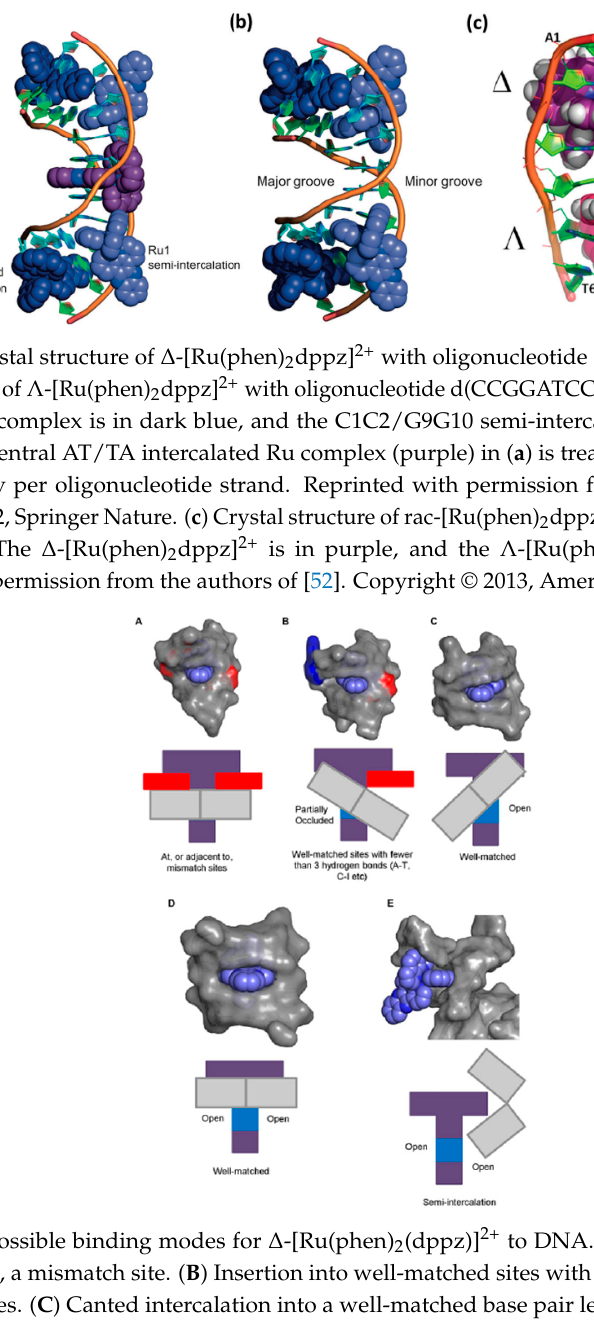
Molecules 2019 , 24 , x FOR PEER REVIEW 7 of 16 metallo-insertion, whereby the ruthenium complex (red) inserts the dppz ligand into the DNA duplex (grey) at the mismatched sites through the minor groove, extruding the mispaired adenosines (blue); (2) metallo-intercalation, whereby the complex (green) binds between two well-matched base pairs; (3) end-capping, whereby the complex (yellow) stacked with the terminal Watson-Crick pair of the duplex. Reprinted with permission from the authors of [26]. Copyright © 2012, Springer Nature. Cardin et al. systematically characterized the crystal structure of Λ -[Ru(phen) 2 dppz] 2+ and Δ -[Ru(phen) 2 dppz] 2+ with different sequences of a DNA strand. A brief introduction of the binding mode between [Ru(phen) 2 dppz] 2+ and the DNA helix was stated as follow [27,52,54,55]: (1) Firstly, in the crystal structures of Λ -[Ru(phen) 2 dppz] 2+ with two oligonucleotide duplexes, the dppz ligand intercalated symmetrically and perpendicularly from the minor groove at the central TA/TA step of d(CCGGTACCGG) 2 , but not at the central AT/AT step of d(CCGGATCCGG) 2 (Figure 5a,b). In both of the structures, however, a second ruthenium complex linked the duplexes through the combination of a shallow angled intercalation of dppz into the C1C2/G9G10 step at the end of the duplex, and the semi-intercalation of phen into the G3G4 step of an adjacent duplex. In each case, the complex intercalates DNA through the minor groove of B-DNA [27]. (2) Secondly, the crystal structure showed that both of the enantiomers of Ru(phen) 2 dppz 2+ bound to a single d(ATGCAT) 2 duplex and Δ -[Ru(phen) 2 dppz] 2+ were better fitted to the right-handed DNA duplex, because the Λ -Ru(phen) 2 dppz 2+ would clash with the nucleic acid backbone (Figure 5c). Both of the enantiomers intercalated from the minor groove in such a way that a phen ligand was stacked against a nucleoside sugar. However, the intercalation of the two enantiomers was distinct with different orientations. The orientation of the dppz was of great importance in understanding the different luminescence behavior of the two enantiomers; water has access to only one phenazine N atom in the Δ -[Ru(phen) 2 dppz] 2+ -bound DNA, whereas for the Λ -[Ru(phen) 2 dppz] 2+ , water can readily access both of the phenazine N atoms [52]. (3) Thirdly, in 2016, the first X-ray crystal structure of a